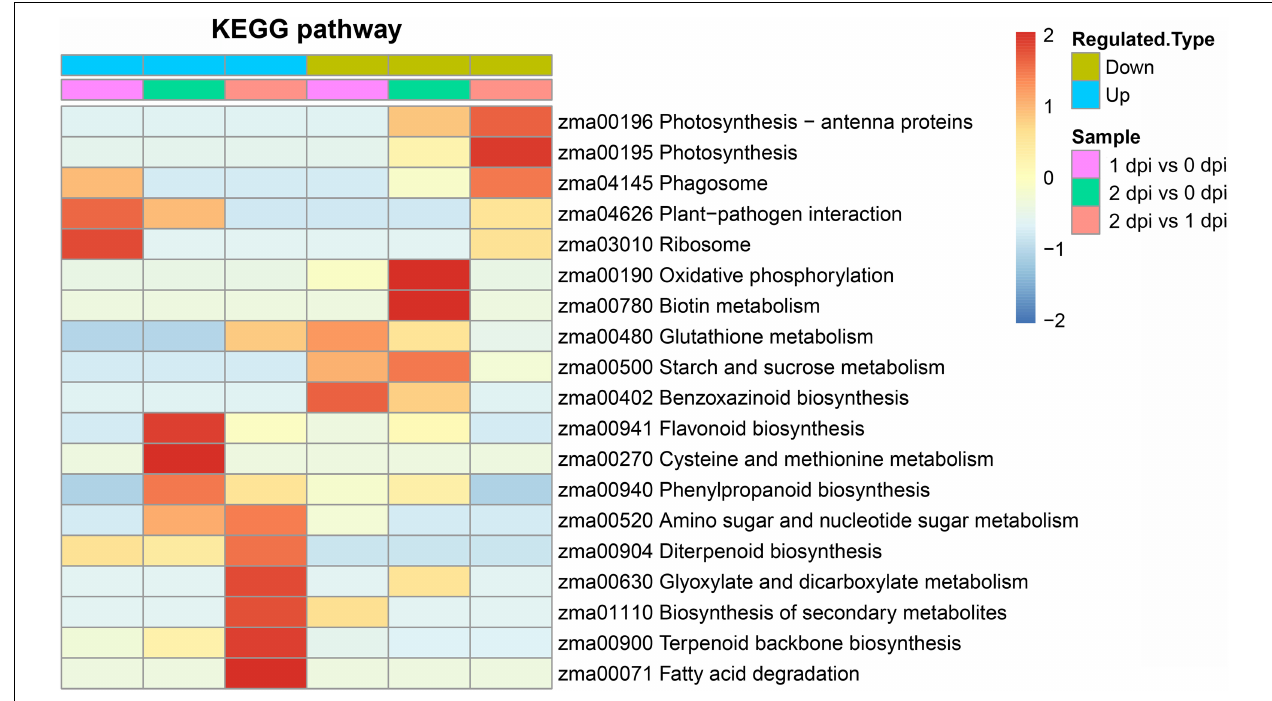
FIGURE 5 | Kyoto encyclopedia of genes and genomes (KEGG) enrichment analysis of upregulated and downregulated DEPs between 0, 1, and 2 dpi. The colors from blue-to-red represent the significance level of the KEGG pathways from low to high.